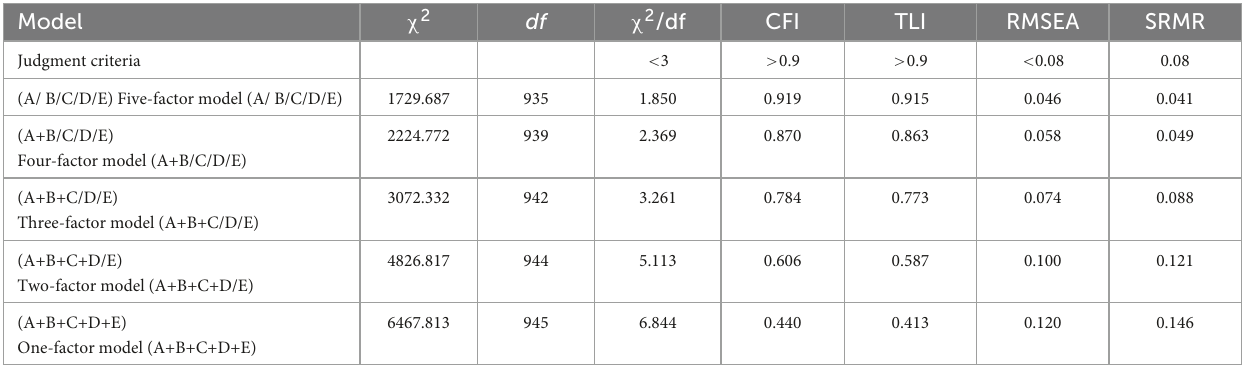
TABLE 2 Confirmatory factor